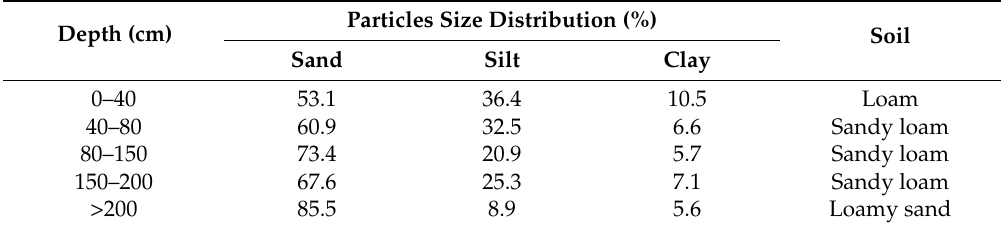
Table 1. Soil texture of the experimental